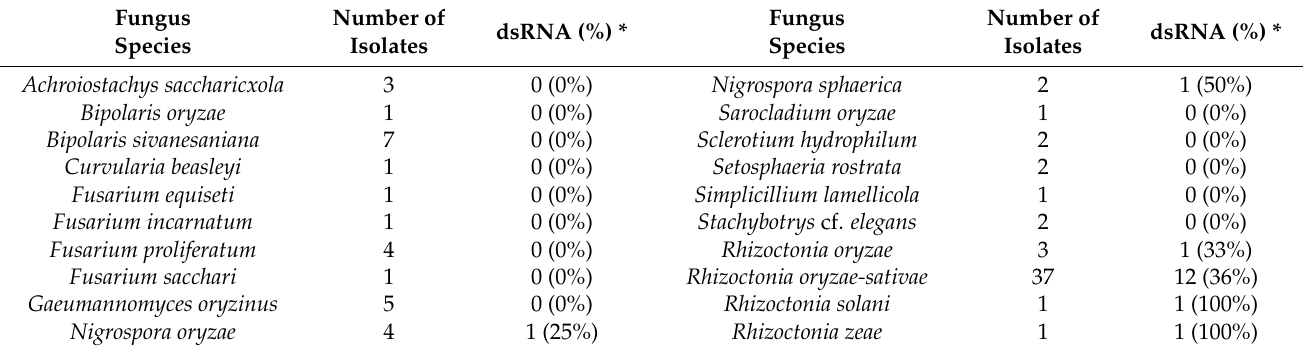
Figure 1. Isolation of rice pathogenic fungi and mycovirus dsRNA profiles. ( A ) Rice sheaths with the blighted symptoms. Diseased leaf tissues were collected from paddies in Thailand and further subjected to single fungal species isolation. ( B , C , and D ) Colony morphology of isolated fungi including Rhizoctonia oryzae-sativae (TSS190505 isolate) ( B ), Nigrospora oryzae (TSD190109 isolate) ( C ), and Rhizoctonia solani (TSD190117 isolate) ( D ). ( E ) Electrophoretic profile of dsRNAs purified from fungal isolates. The majority of the dsRNA elements appeared to be within the size range of approximately 1.5 to 2 kbp. Green letters above the panels indicate R. oryzae-sativae isolates, while those in black letters are others. Table 1. List of fungal species roughly predicted by BLASTn analysis of ITS sequences, and presence of dsRNA in each possible species.